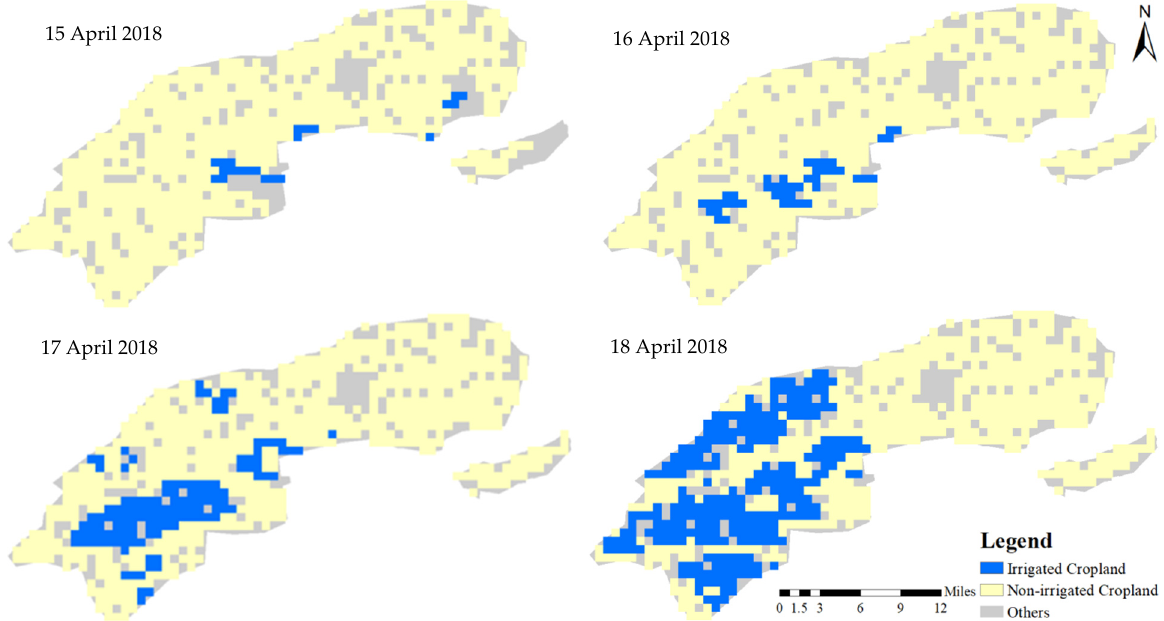
Figure 8. Sensitivity analysis of the DTR Threshold. ( a ) threshold sensitivity, ( b ) threshold accuracy.